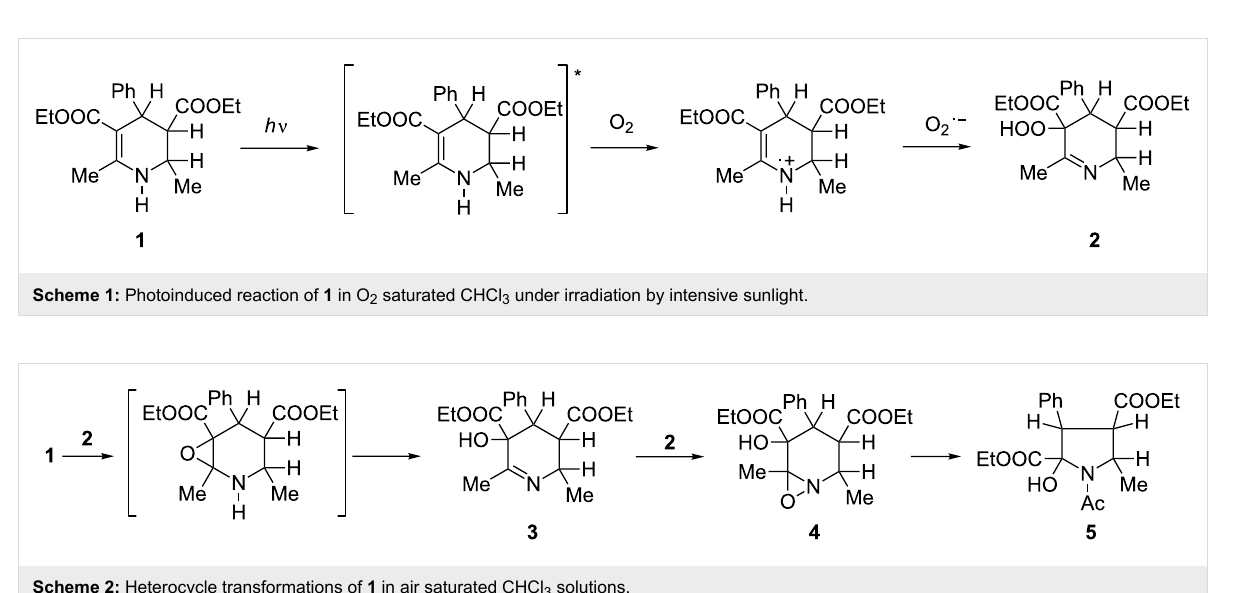
If a series of UV spectra is recorded after subsequent periods of 1 min irradiation of the sample with an external UV lamp (254 nm, 8 W), the absorption band decreases and no new band appears in the range of 250–900 nm (Figure 3). If the irradi- ation of the sample is stopped for 1 min, the reaction halts, and the recorded UV spectrum exactly repeats the previous